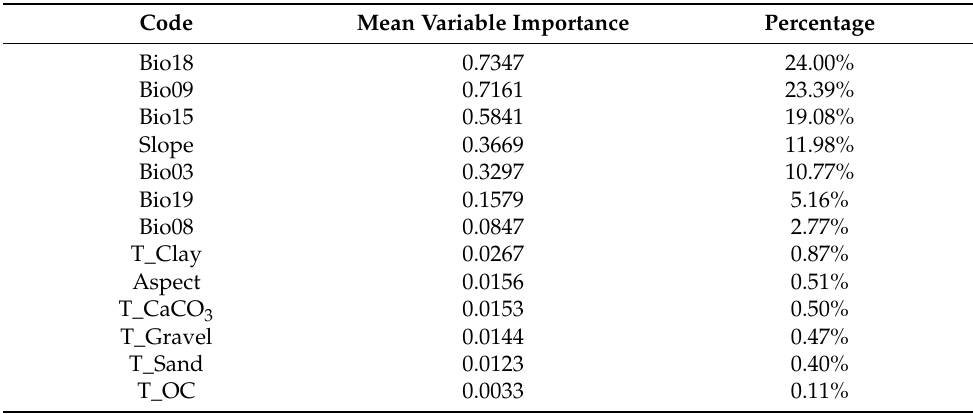
Table 3. Mean variable importance and percentage of 13 environmental variables included in the ensemble model for Cypripedium japonicum .